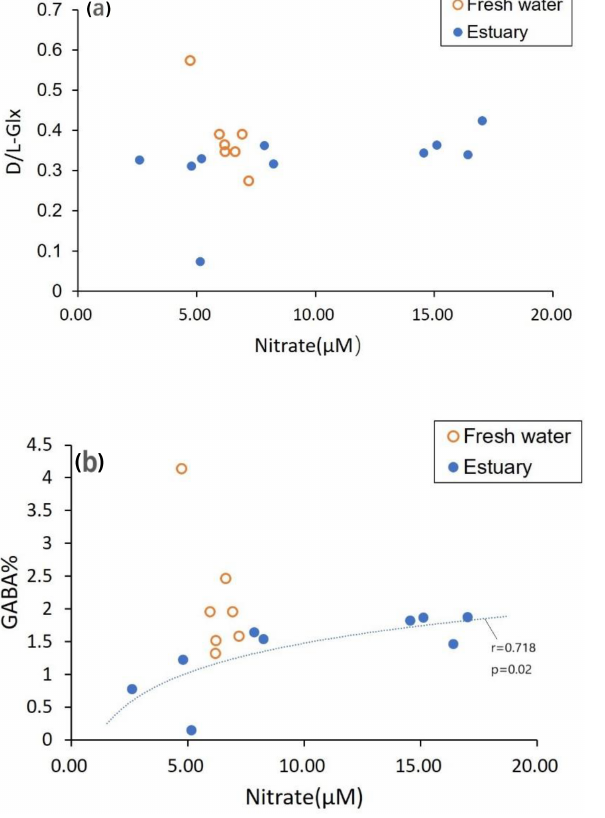
Figure 8. Dissolved OM composition ( a D- / L-Glx, b GABA per- centage) and its relationship with nitrate concentration. Nitrate con- centrations are taken from Jiang et al.